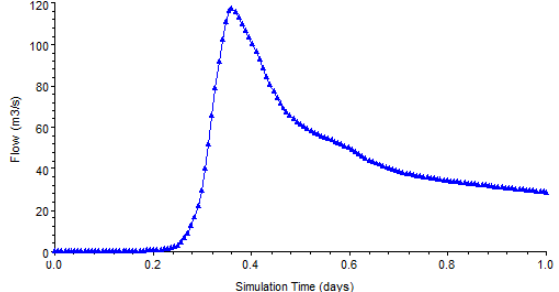
Figure 3. The inflow boundary condition used in the 2D river flow